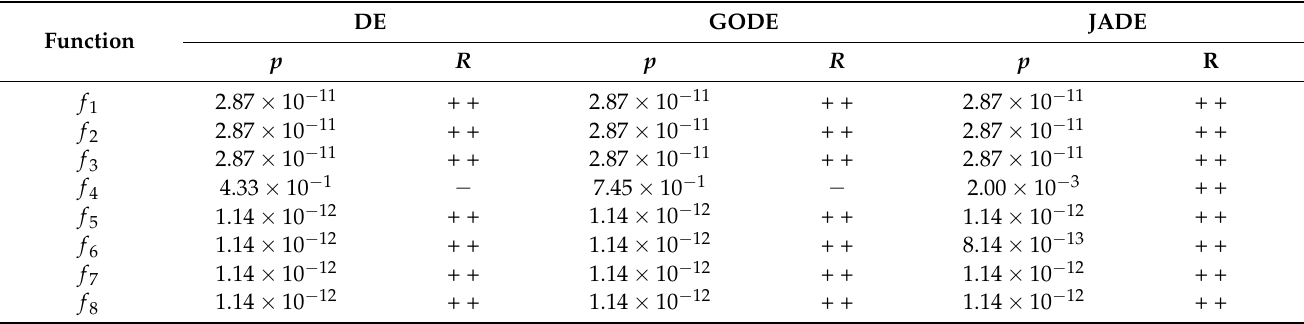
Table 5. Wilcoxon rank-sum test